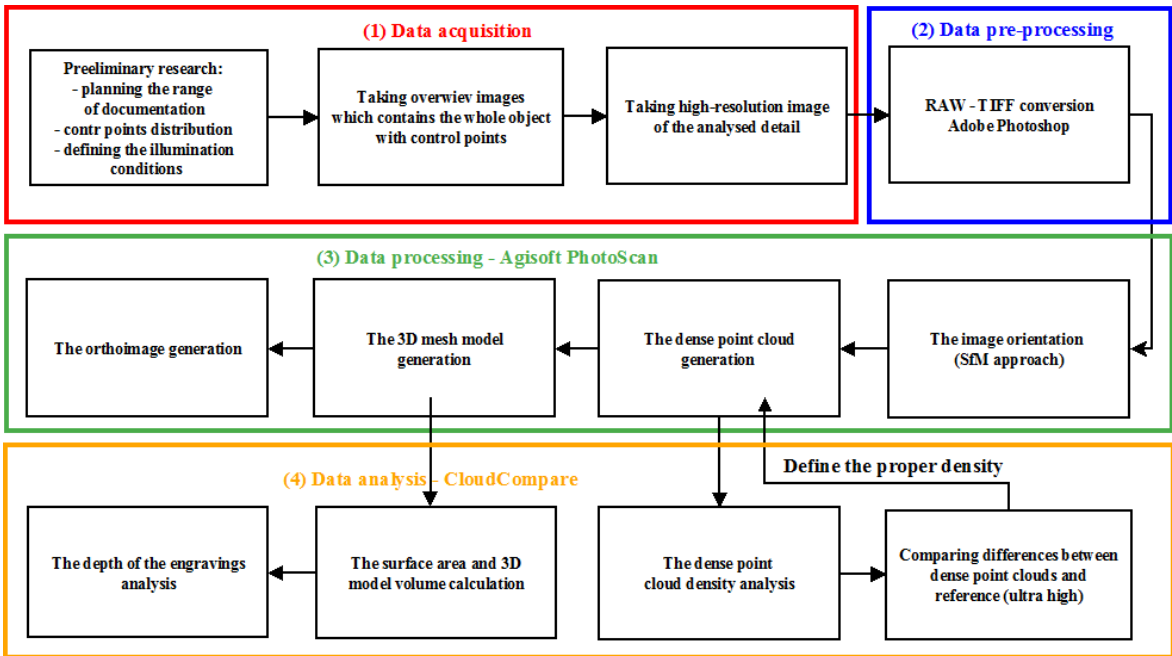
Figure 2. Technological processes of developing engineering documentation for historical